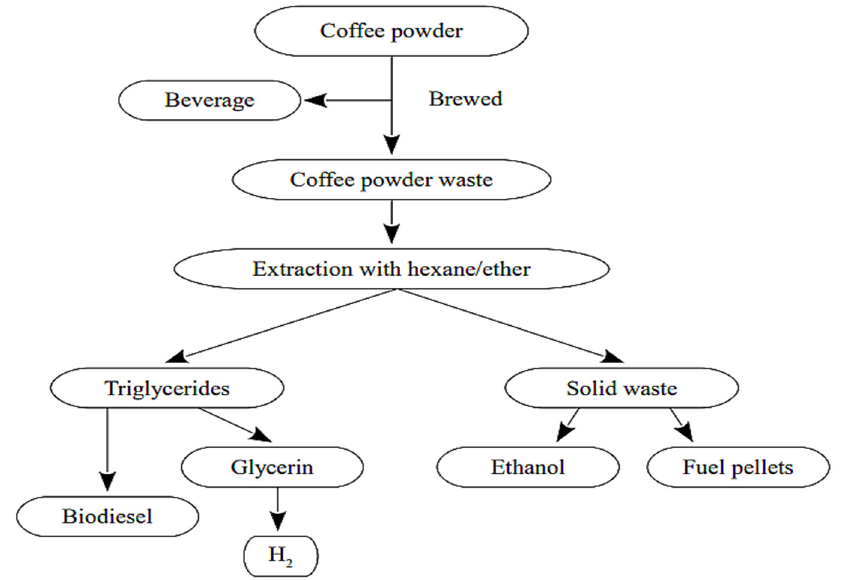
Figure 4. Schematic presentation of biodiesel and fuel pellet production process from spent coffee grounds. Own compilation based on literature data [78].